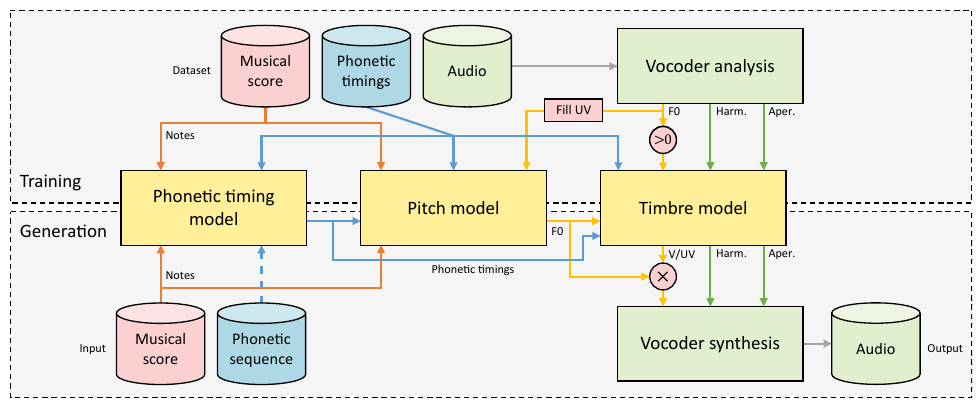
Figure 1. Diagram depicting an overview of the system with its different components. Here, V/UV is the predicted voice/unvoiced decision, and the Fill UV block fills unvoiced isegments by